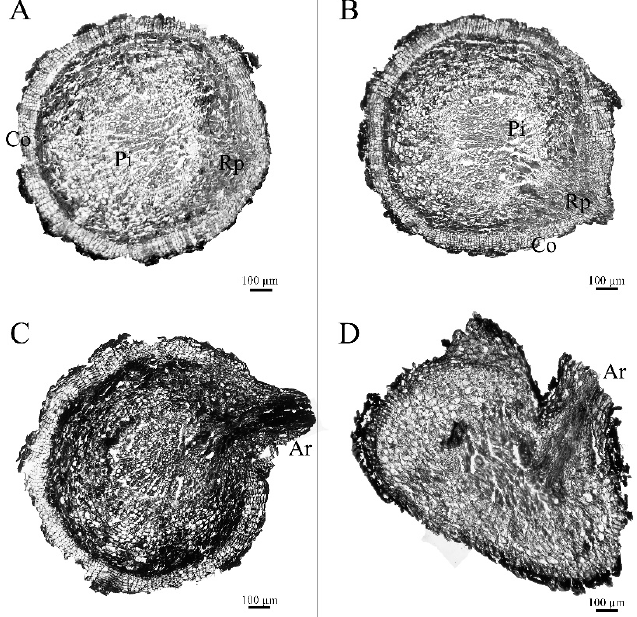
Figure 2. Morphological anatomic observation of Paeonia suffruticosa adventitious roots: ( A ). root primordium ungerminated period; ( B ). root primordium induction period; ( C ). root primordium convex; ( D ). root emergence; Co.—cortex; Rp.—adventitious root primordium; Pi.—pith; Ar.—adventitious root). The scale bar is 100 µm.